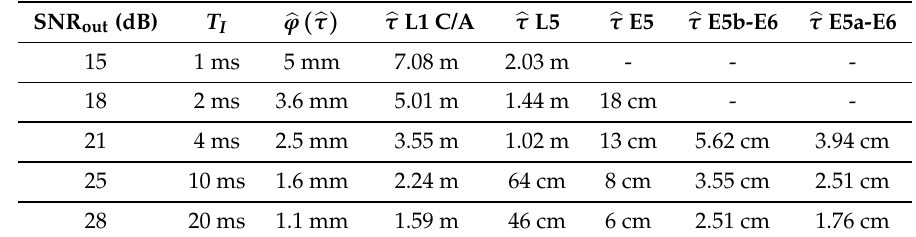
Table 3. Phase and Time-delay Estimation Standard Deviation for: GPS L1 C/A ( F s = 10 MHz), L5 ( F s = 10 MHz), Galileo E5 ( F s = 120 MHz), E5b-E6 ( F s = 240 MHz), and E5a-E6 ( F s = 400